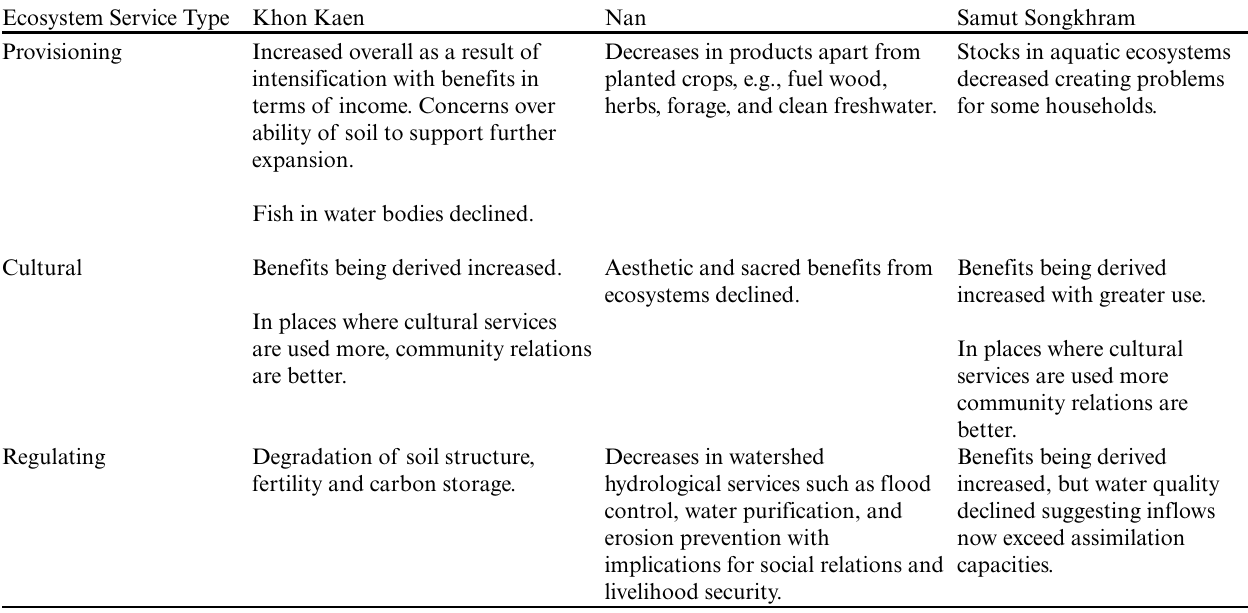
Table 3 . Trends and conditions of selected ecosystem services important to human well-being in the three provinces. Ecosystem Service Type Khon